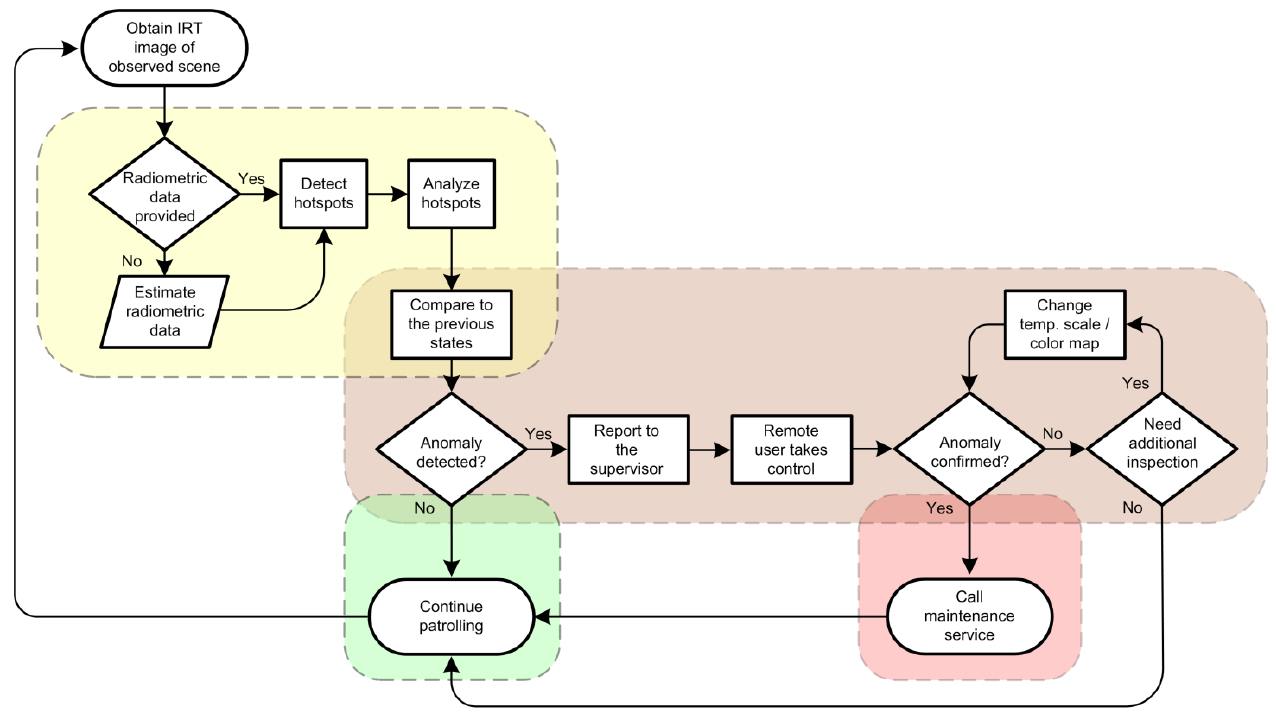
Figure 16. The flowchart of the temperature-anomaly-detection algorithm.